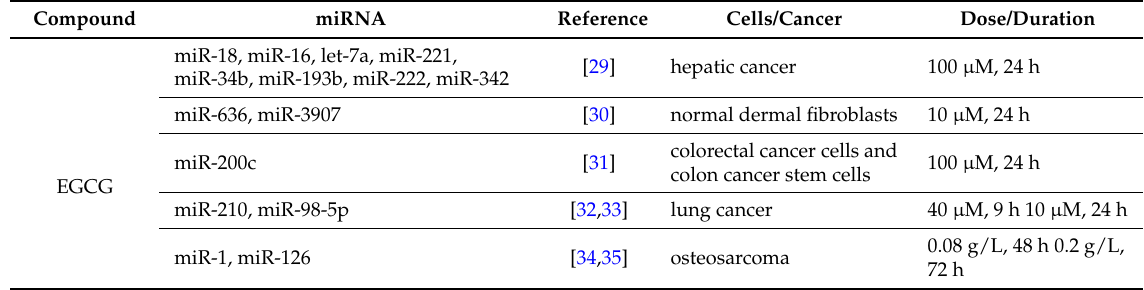
Table 2. MicroRNAs modulated by bioactive compounds; the effect on human normal or cancer